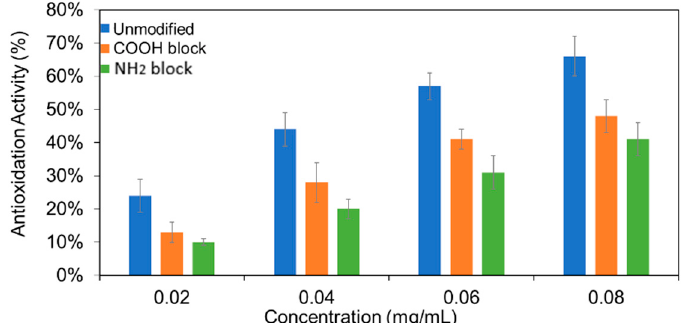
Figure 3. The calculated antioxidation activity of unmodified, –COOH-blocked, and –NH 2 -blocked CNDs for multiple concentrations. Each measurement at a given concentration was repeated three times. The means and standard deviations were calculated.